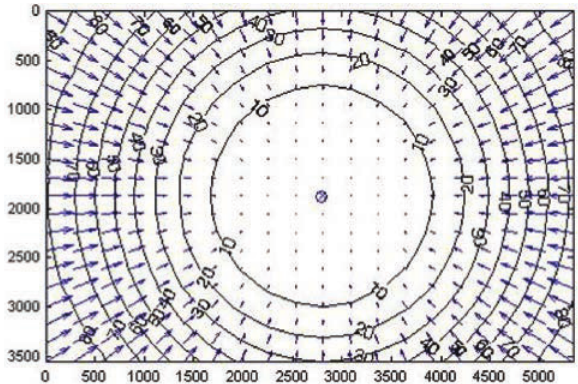
Fig. 5. Distortion of camera lens